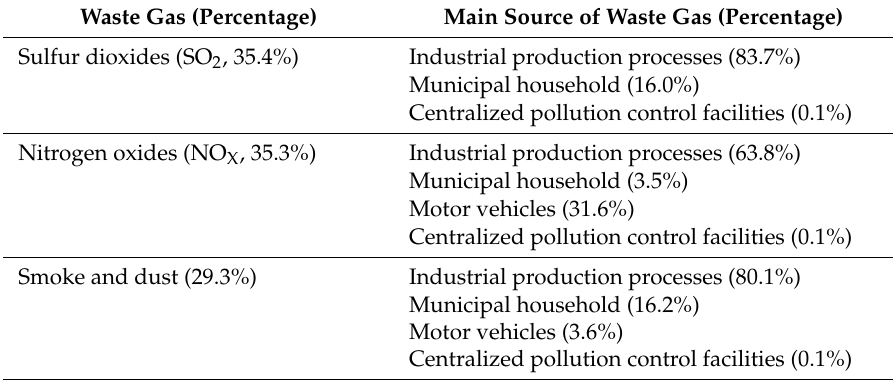
Table 1. Main sources of waste gas in China’s regular air quality grading